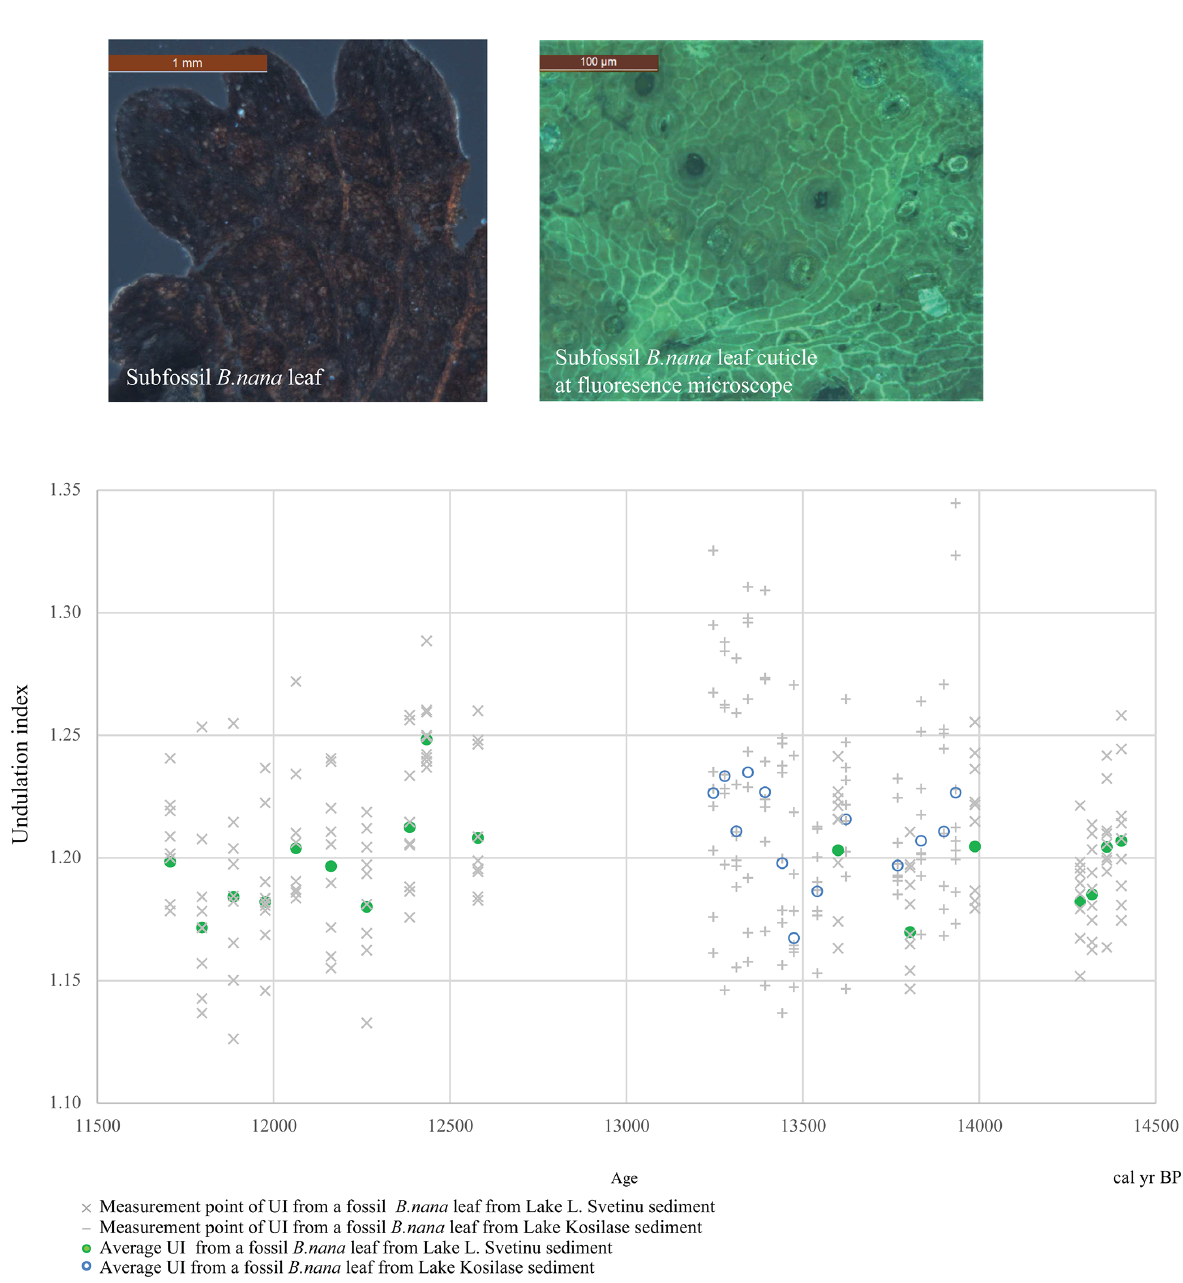
Figure 3. The results of the undulation index (UI) measurements. The sample cloud represents the measurements, and the dots display the average values per sample. Two representative photographs of a Betula nana subfossil leaf and its cuticle under fluorescence microscopy. The scale is 1mm for the subfossil leaf photograph and 100µm for the cuticle